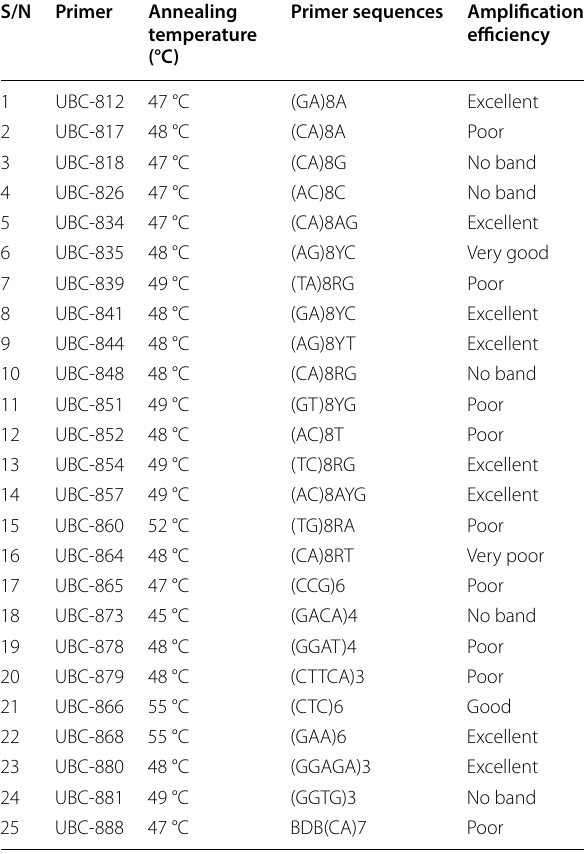
Table 2 List of ISSR primers along with their annealing temperature, respective sequences and amplification efficiency used during optimization